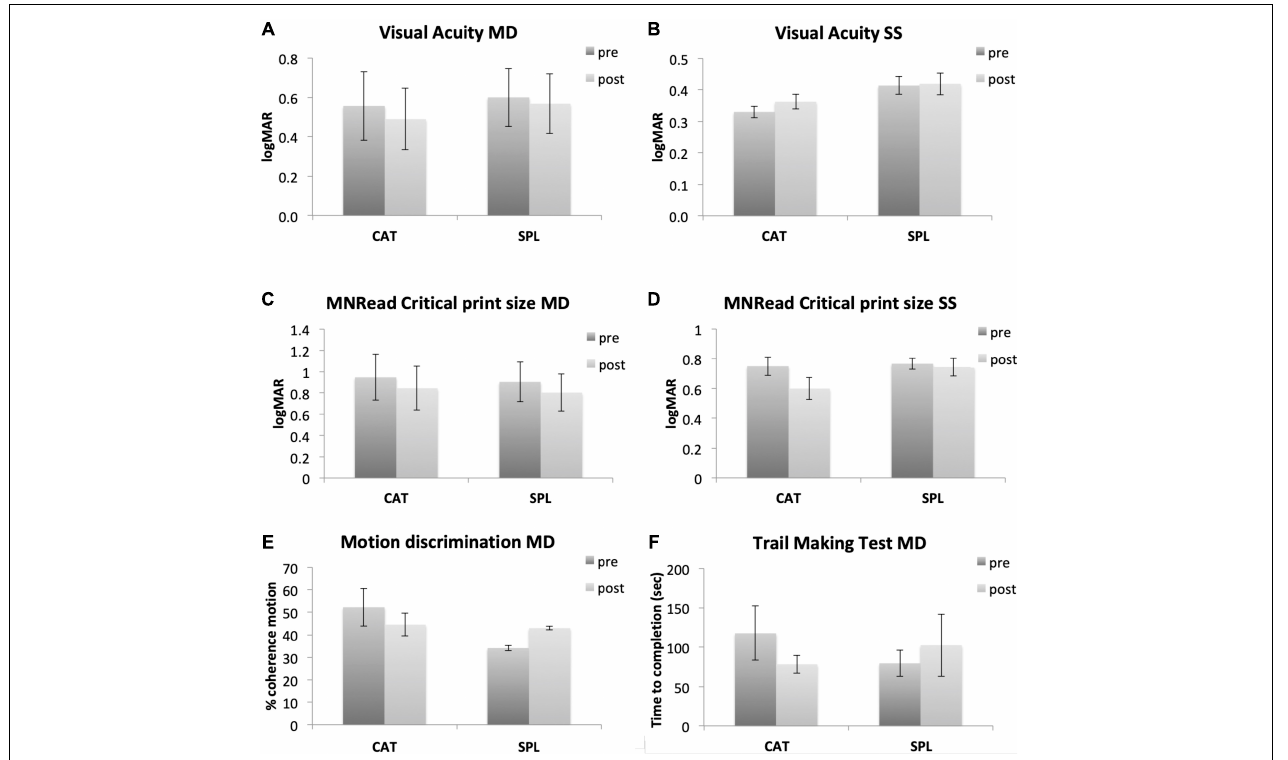
FIGURE 4 | Preliminary results from our perceptual learning study comparing a standard perceptual learning (SPL) with a coordinated attentional training (CAT). In the first two rows, left side shows data from MD participants ( A,C for visual acuity and MNRread respectively), while right side shows data from healthy participants trained with gaze-contingent, simulated scotoma ( B,D for visual acuity and MNRread respectively). The last row shows additional assessment tasks only collected in MD participants (motion direction discrimination and Trail Making Test, E,F respectively). In SPL training, the Gabor target was always presented in the center of the screen and accompanied by a neutral acoustic cue. In CAT the target could appear anywhere on screen, thus involving visual search and gaze re-orienting. The target presentation was accompanied by a visual cue (a white circle around the target) and an auditory cue whose pitch and interaural difference were matched to the target location on screen. In the Trail Making Test, participants are presented with a piece of paper with circles containing numbers in random order and asked to use a pencil to connect them in ascending order as quickly as possible. The dependent measure of this test is the completion time expressed in